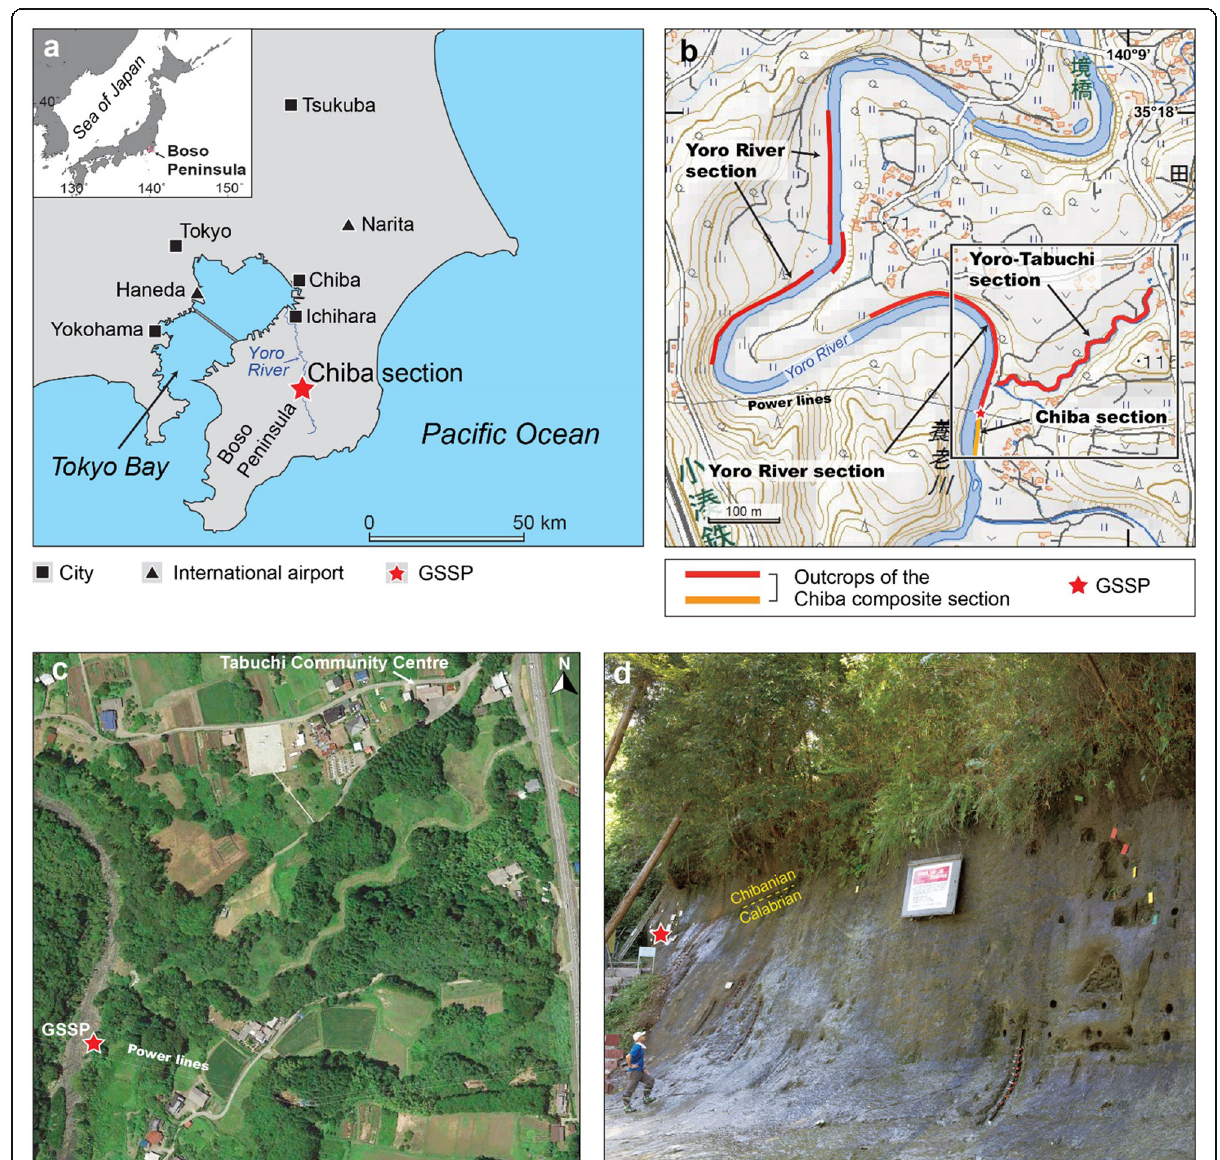
Fig. 1 Location of the Chiba and Yoro-Tabuchi sections examined in the present study. a Location of the Chiba section in the central Boso Peninsula. Selected cities and the two nearby international airports of Haneda (Tokyo International Airport) and Narita (New Tokyo International Airport) are shown. b Topography of the Yoro River in the vicinity of the Chiba and Yoro-Tabuchi sections. The Chiba section forms part of the Yoro River section, and is continuous with the Yoro-Tabuchi section. All are part of the Chiba composite section. The Global Boundary Stratotype Section and Point (GSSP) is located on the east bank of the Yoro River near where the power lines cross overhead (from fig. 8c of Suganuma et al., in press). c Google Earth image of the square shown in ( b ). d Chiba section showing the position of the GSSP (red star) which defines the boundary between the Calabrian and Chibanian stages and Lower and Middle Pleistocene subseries (from fig. 10a of Suganuma et al., in